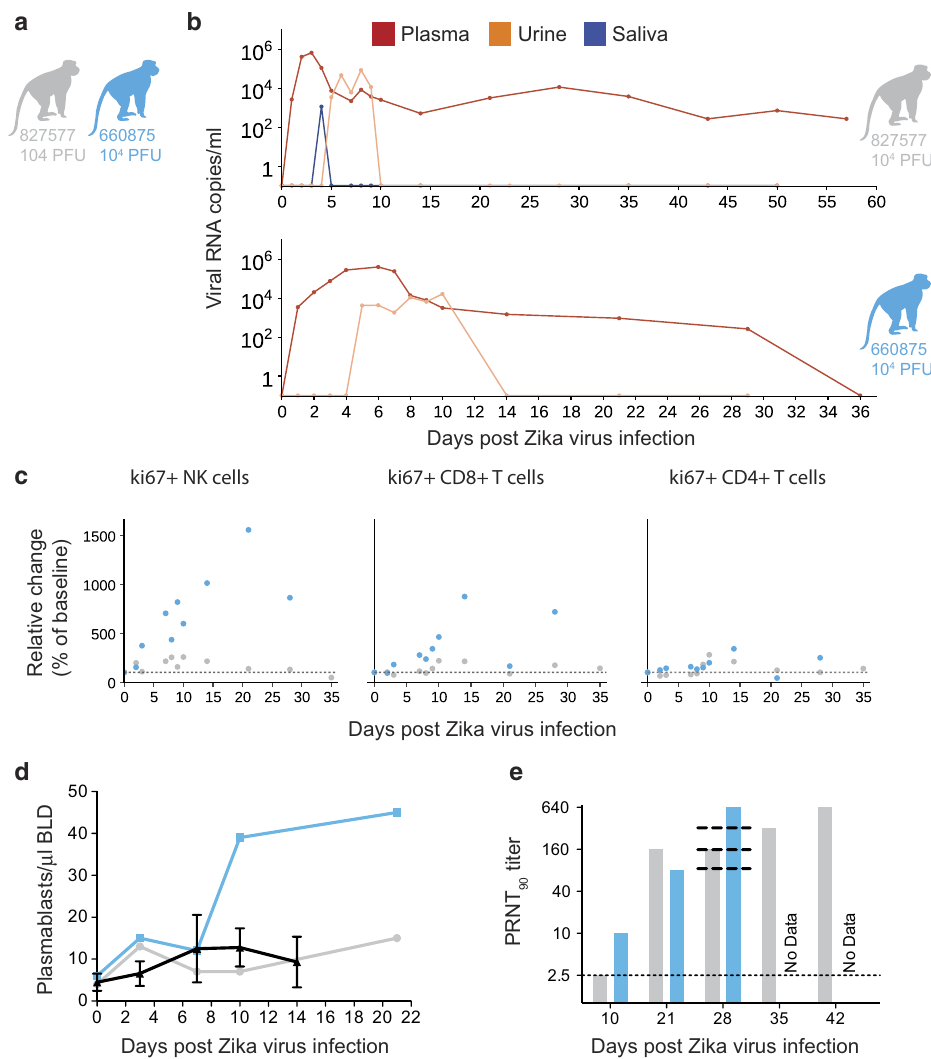
Figure 4 | Characterization of Zika virus infection in animals infected during the first trimester of pregnancy. ( a ) Schematic of animals presented in this figure as cohort 3. Dots, lines and bars representing each animal match in colour throughout the figure. ( b ) vRNA copies of the plasma, urine and saliva from each pregnant animal. Oral swabs could not be obtained from 660875. ( c ) Absolute numbers of Ki-67 þ NK, CD8 þ T-cell and CD4 þ T-cell populations presented as a percentage relative to baseline ( (cid:2) 100) over time in each animal. ( d ) Plasmablast expansion over time from each pregnant animal. The average plasmablast expansion of cohorts 1 and 2 animals infected with the 10 4 p.f.u. is presented by the black line. Error bars represent s.d. ( e ) PRNT 90 titres over time for each animal. Lines representing the titres from cohort 2 animals are overlaid at 28d.p.i. for reference (top to bottom: 610107, 181856 and animal (Fig. 4d). nAbs were detected by 21 d.p.i. for 827577 and 10 d.p.i. for 660875 and were similar to the cohort 2 (non-pregnant) animals at 28 d.p.i. (Fig. 4e). One pregnant animal exhibited an increase in CK above the RI and above levels expected with repeated ketamine sedation and blood collection.